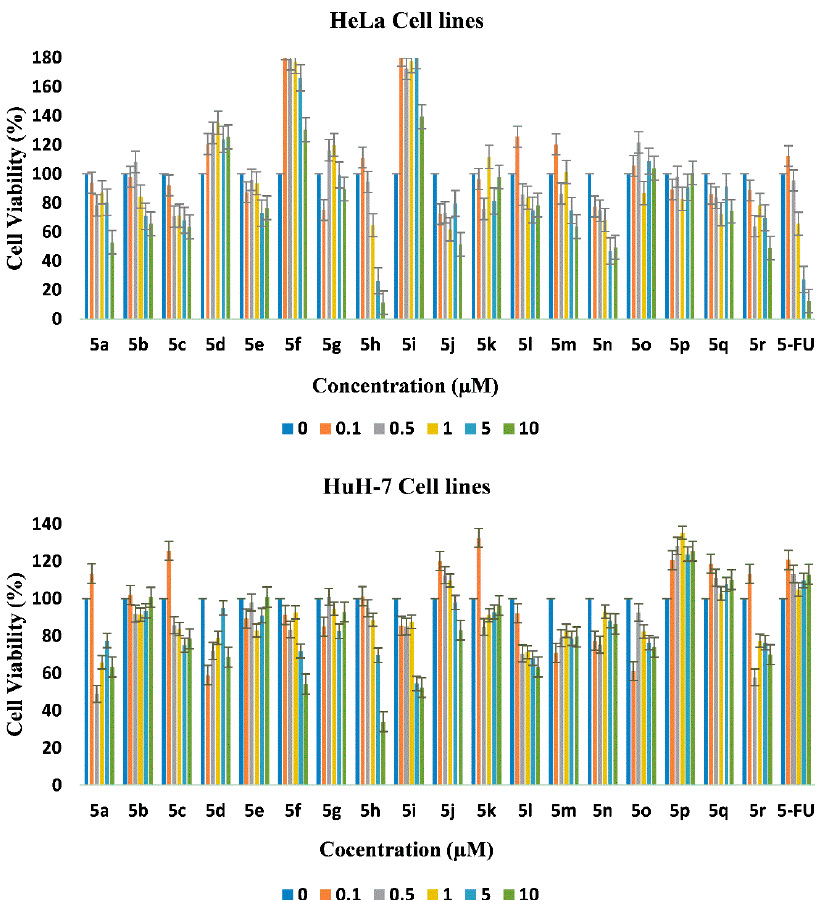
Figure 11. Cell viability profiles of HeLa and HUH-7 tumor cell lines against the treatment of substituted 1,2,3-triazole-uracil analogues for 72 h.